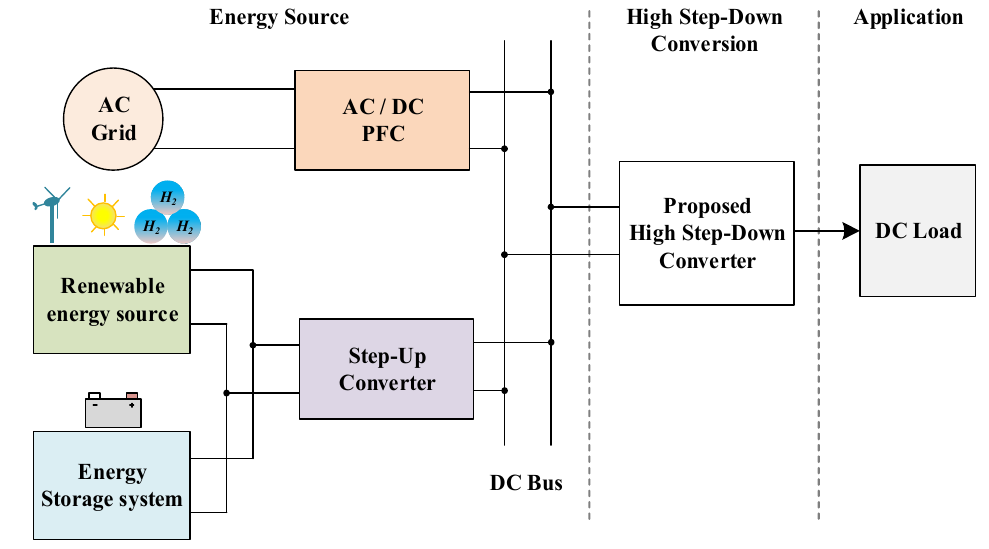
Figure 1. Block diagram of proposed high step-down converter applications.